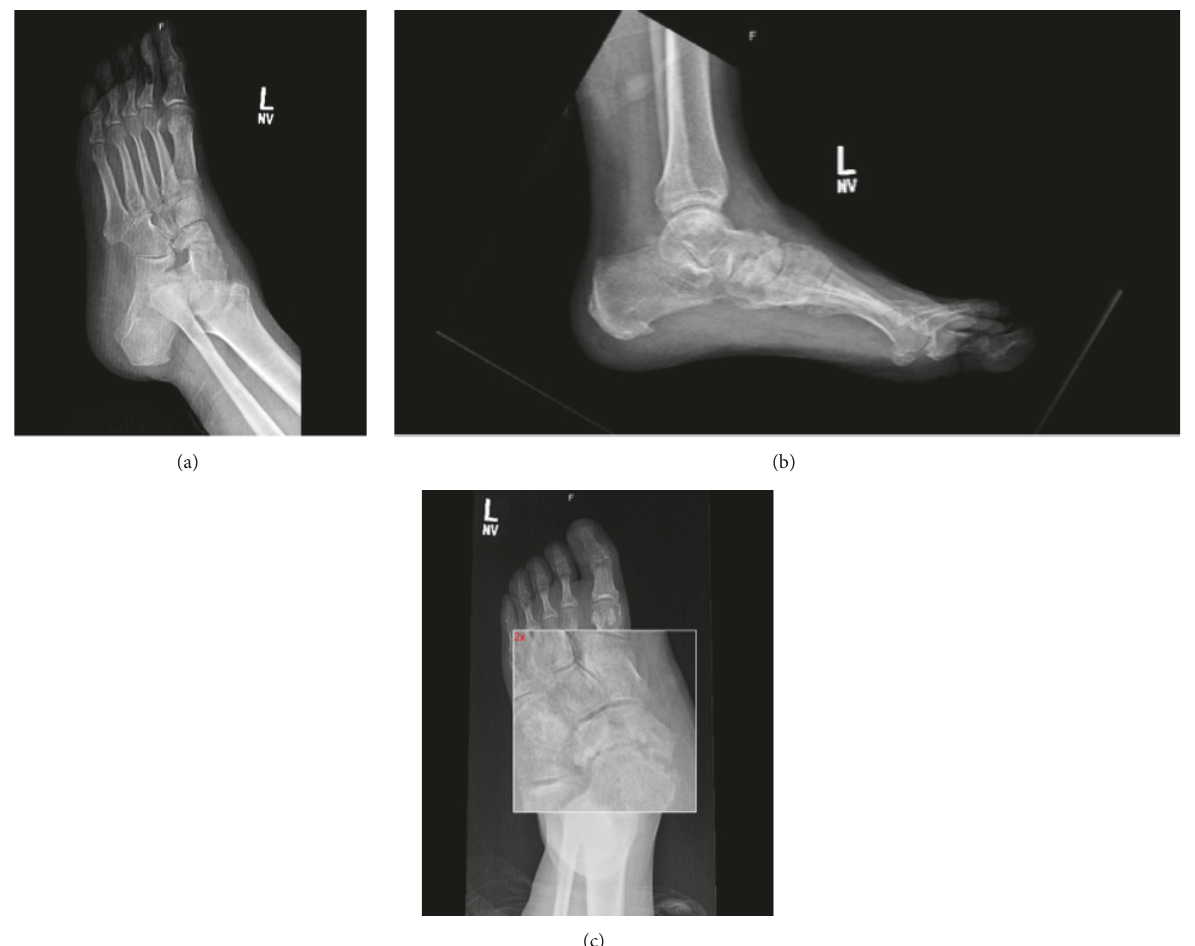
Figure 6: Final radiographs demonstrating development of talonavicular